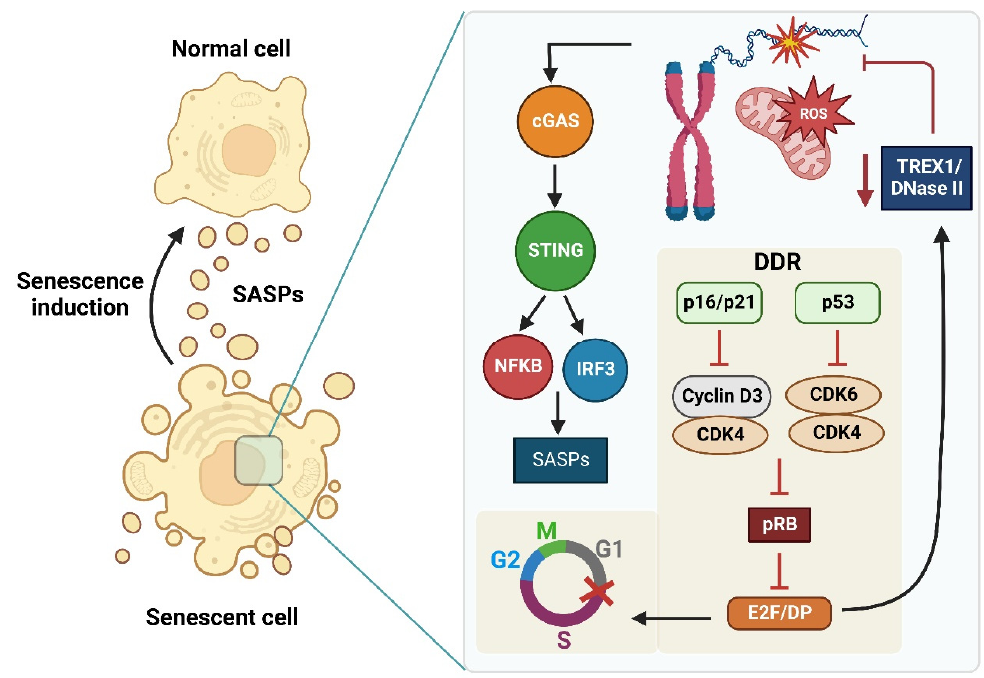
Figure 7. Relationship of the signaling of SASPs, cGAS/STING, ROS, and DDR during senescence. Damaged nuclear or mitochondrial DNA is sensed by cGAS. It activates downstream STING signaling, which generates the increased expression and secretion of SASPs (several types of cytokines such as IL-6, IL-8, and IL-1, among others). SASPs secreted by senescent cells induce senescence activation in the neighbor cells by association with the receptors in the cellular membrane. In addition, damaged DNA causes DDR that activates the cell cycle inhibitors p16/p21 and p53 and the activation of cellular senescence for inhibition of Cyclin-dependent kinases (CDKs) that regulate the cellular cycle. Cytoplasmic DNA can be degraded by DNase II and Three Primer Repair Exonuclease 1 (TREX1), which limits DNA exposure and, thus, cGAS recognition. In addition, the inhibition of the heterodimer of E2F and Dimerization Partner (DP) transcriptional factors, given by Rb, influences the decrease in the expression of nucleases which promotes the accumulation of DNA and the activation of the cGAS/STING pathway during